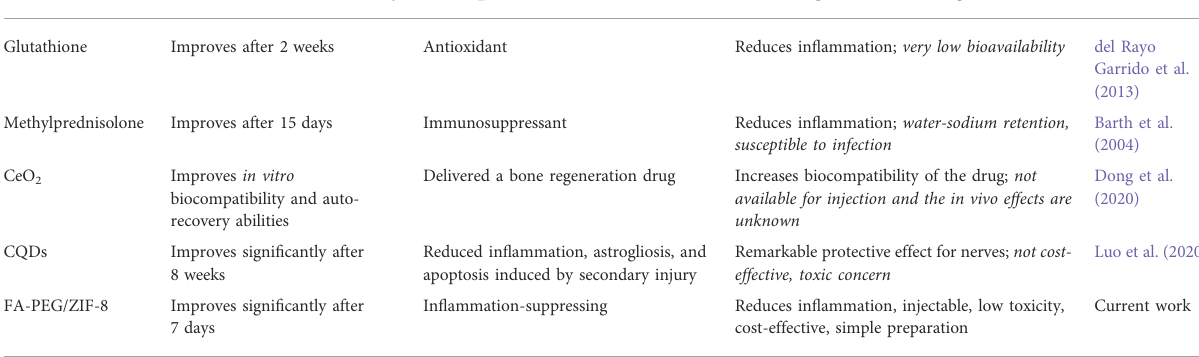
TABLE 2 Comparison of the motor function recovery after SCI by using different medicines. Nanomedicines Motor function recovery Therapeutic